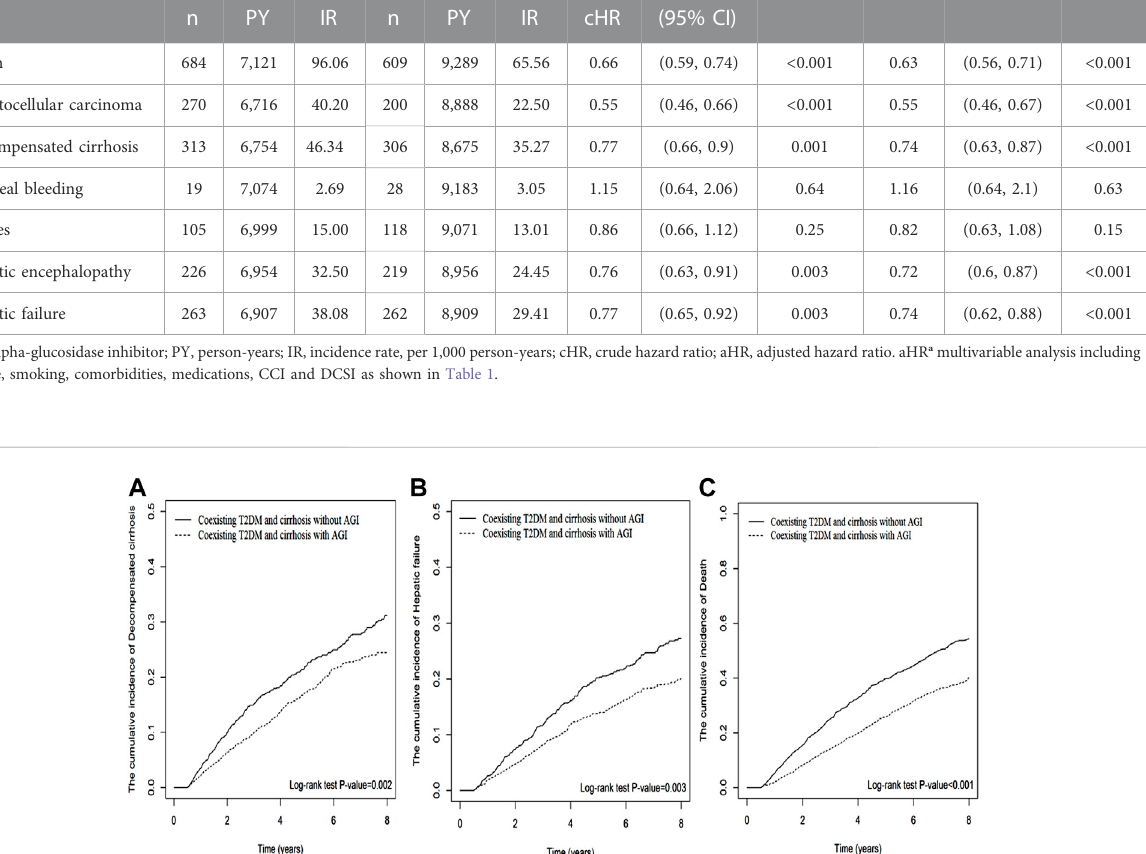
TABLE 2 Hazard ratios and con fi dence intervals for the outcomes between AGI users and non-users. Outcome